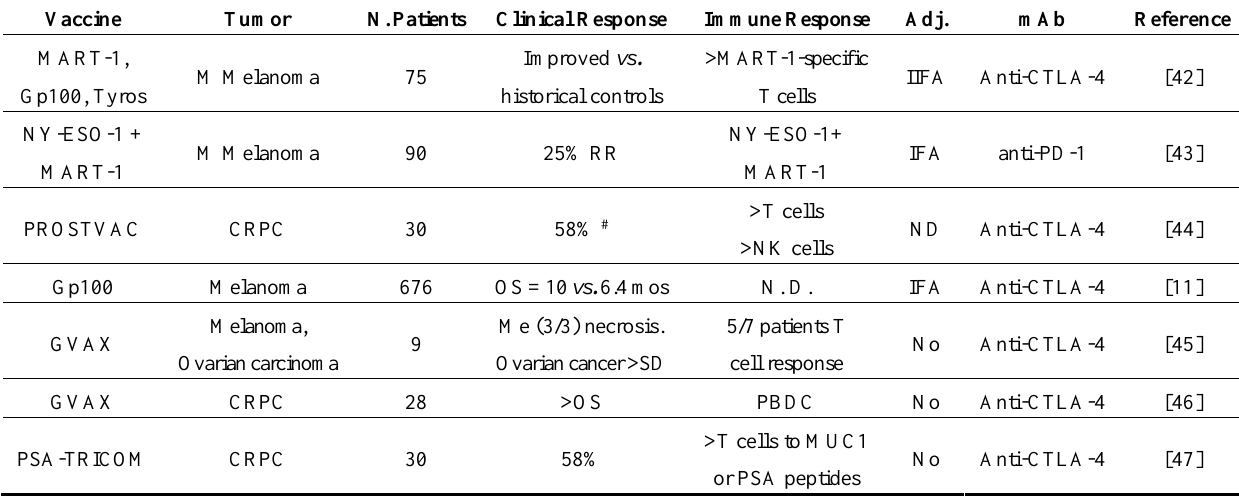
Table 1. Recent trials of combination of immune checkpoint inhibitors and vaccines in human